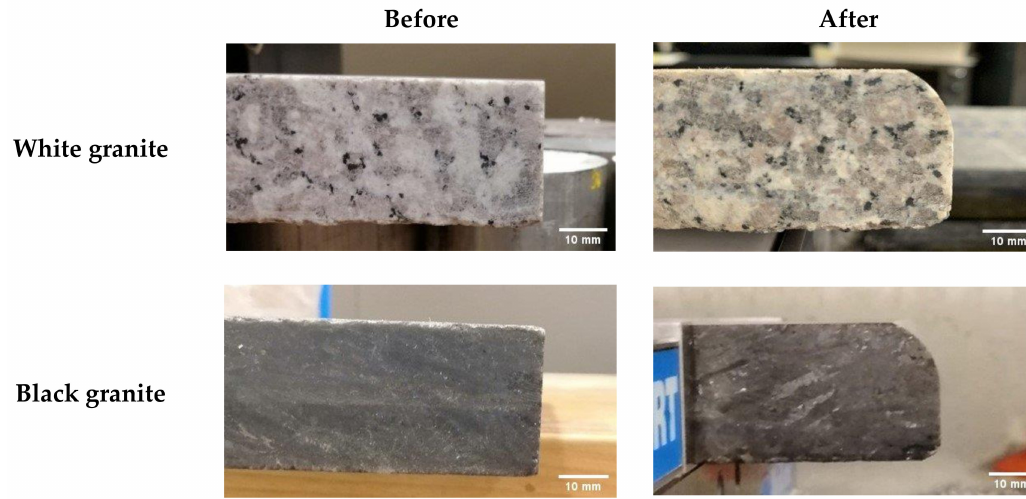
Figure 4. White and black granite samples before and after edge finishing.